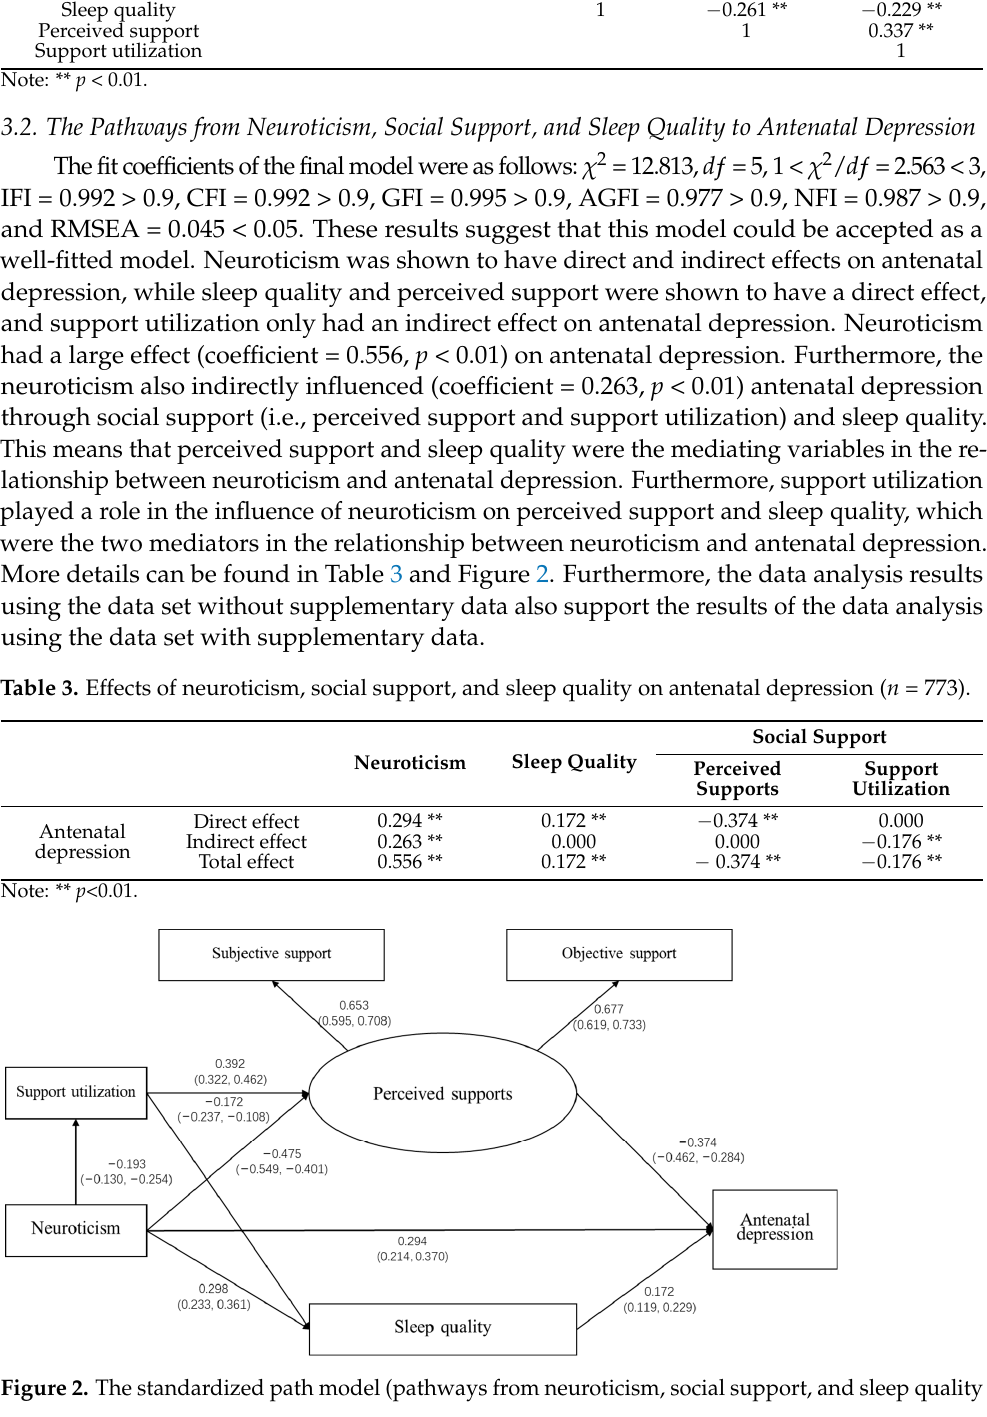
Social Support Sleep Support Perceived Quality Utilization Supports